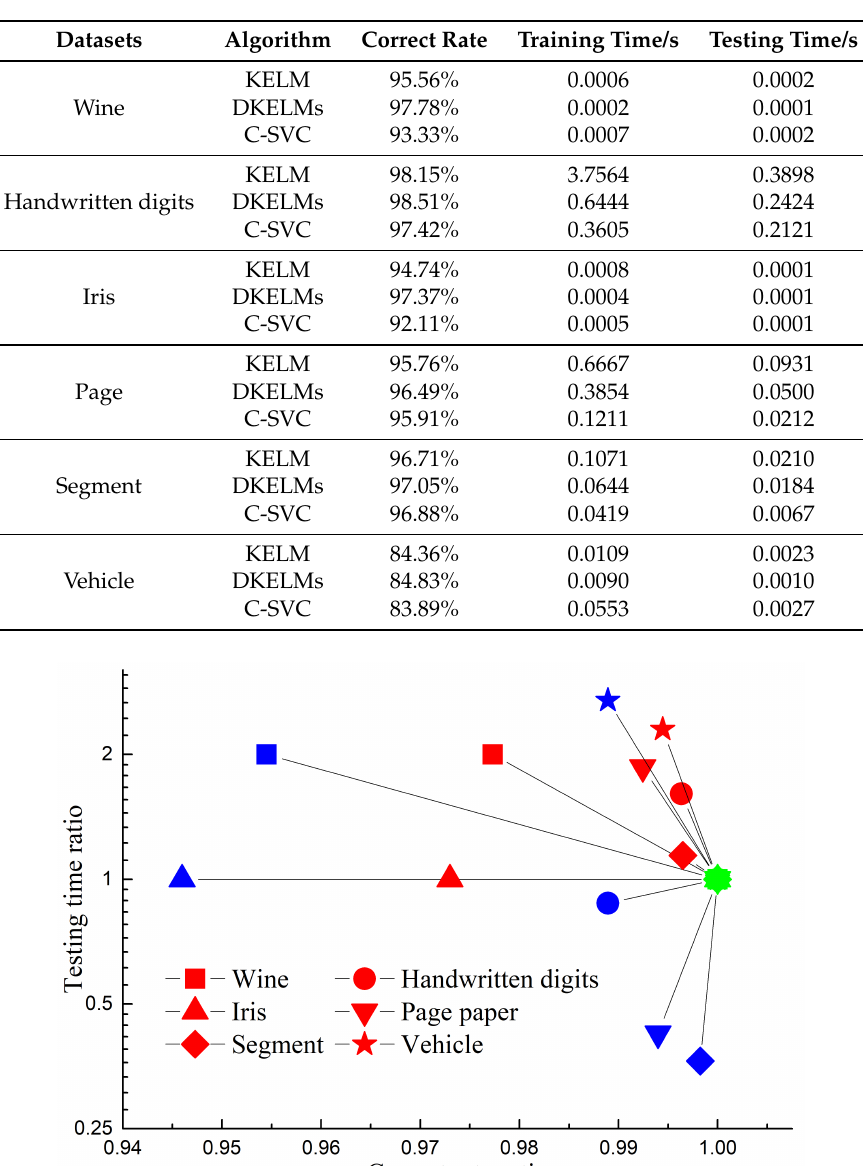
Table 4. Performance of distributed KELM on classification benchmark datasets.